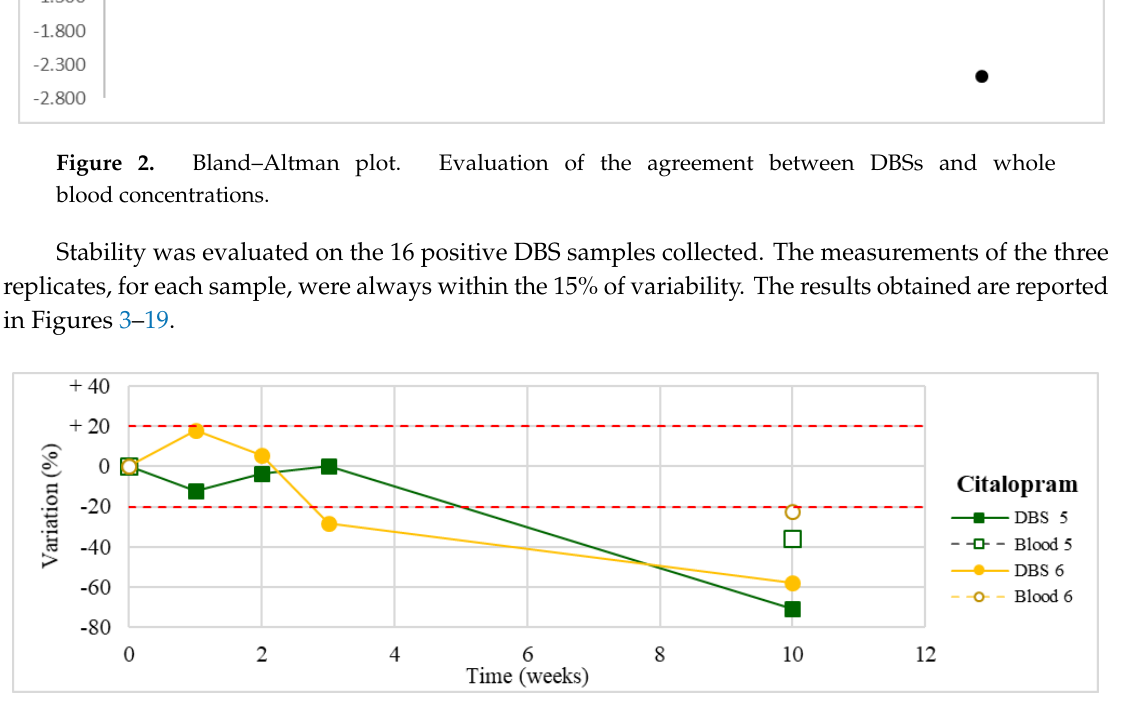
Figure 3. Long-term stability of citalopram ( n = 2) in dried blood spots (DBSs) stored at room temperature and in blood stored at − 20 ◦ C